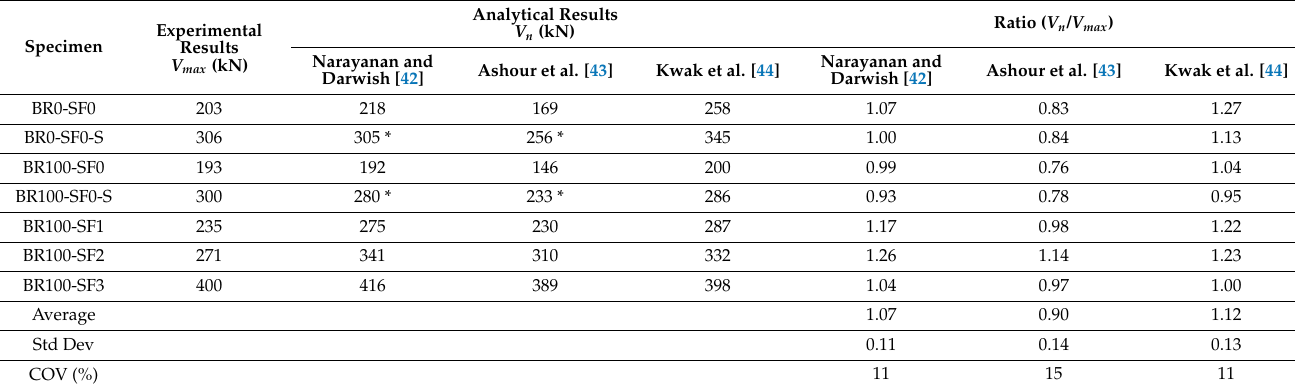
Table 7. Comparison between analytical and experimental